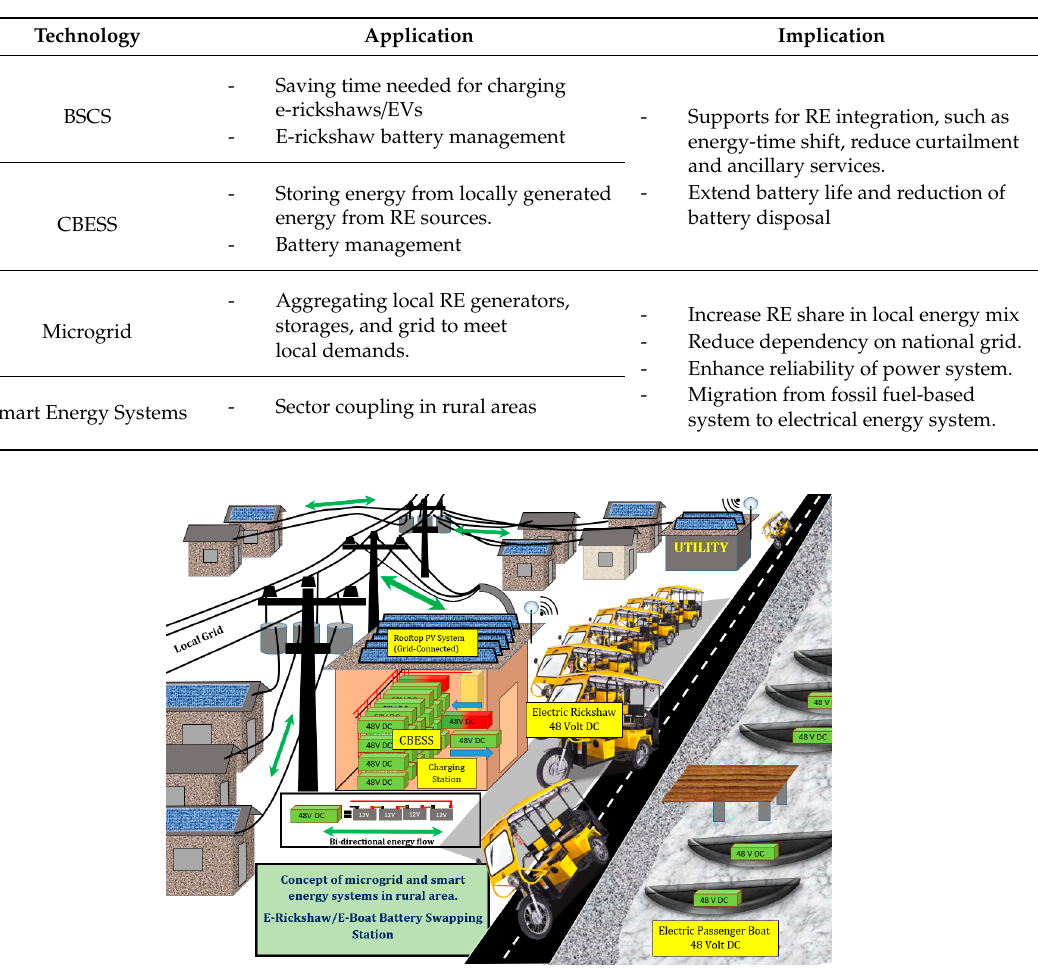
Figure 5. The concept of rural smart energy systems using a BSCS for e-rickshaws. Major components include e-rickshaw or similar transports, distributed/rooftop solar PV, local grid, local utility, and auxiliary battery sets as community battery energy storage system (author’s illustration).